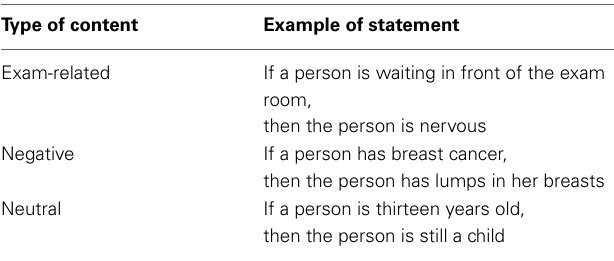
Table 3 | Examples of statements with different